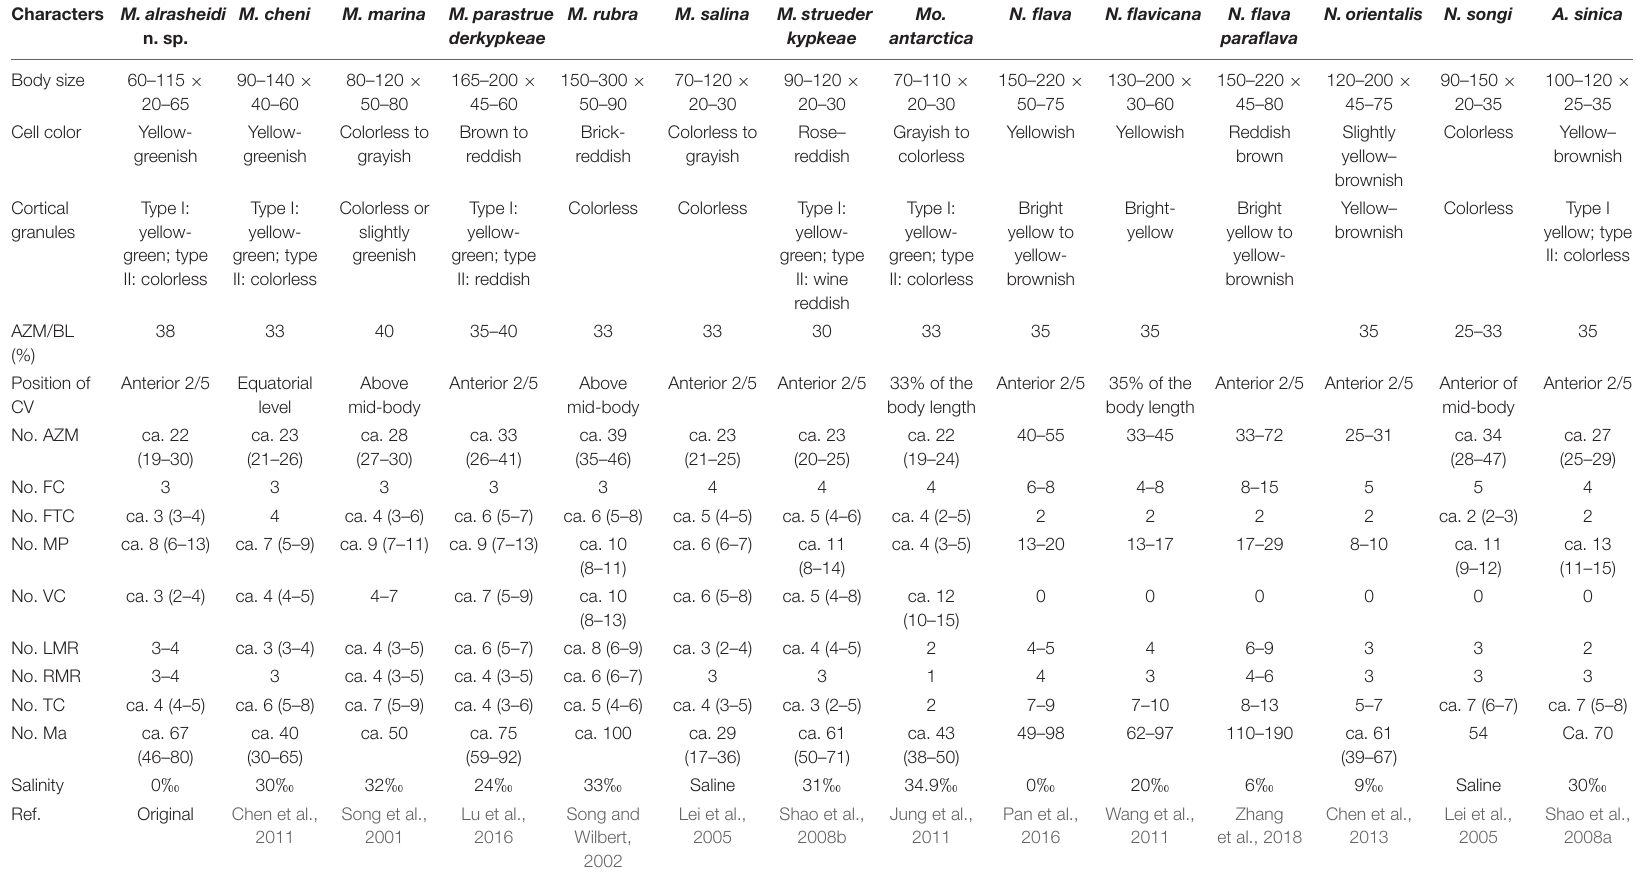
TABLE 2 | Morphometric comparison of Metaurostylopsis alrasheidi n. sp. with closely related species. Characters M.alrasheidi n.